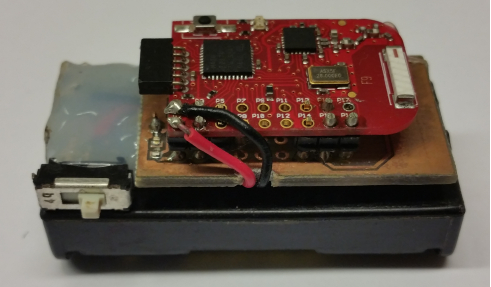
Figure 1. Wearable radio transceiver at 2.4 GHz ISM band. The device is approximately 50 mm × 20 mm × 20